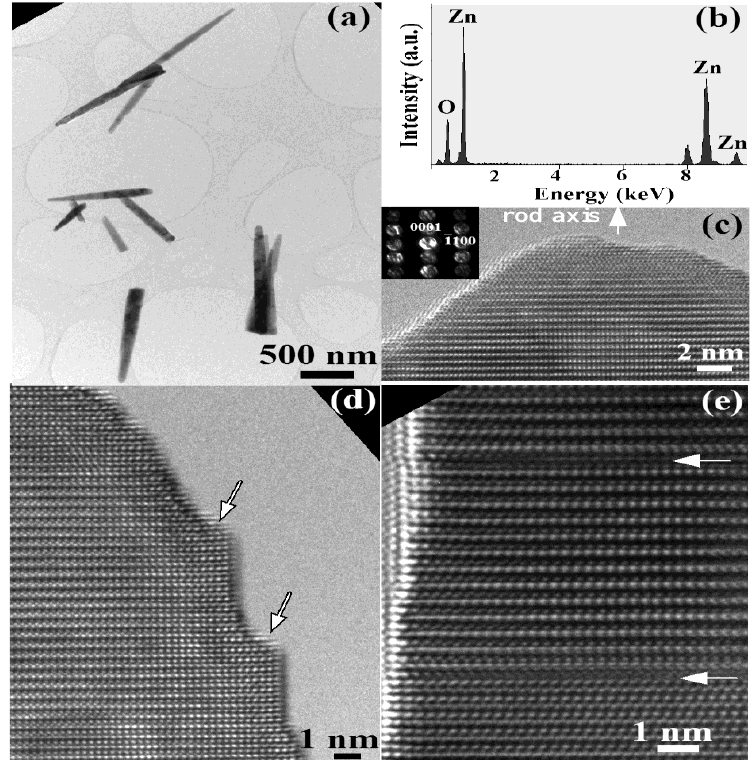
Figure 2. ( A , D , E ) TEM images; ( B ) EDX analysis; and ( C ) SAED pattern from typical ZnO nanorods.